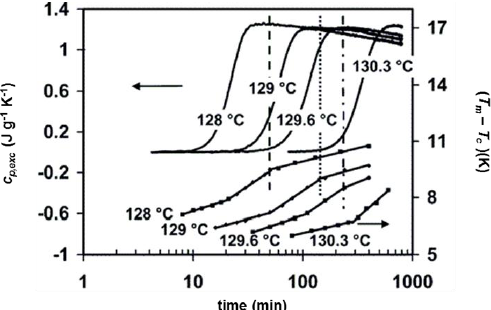
Figure 13. Correspondence between the three stages of the melting temperature ( T m ) evolution, plotted as the difference between the melting temperature and the crystallization temperature ( T c ), and the decay of the excess heat capacity at the indicated crystallization temperature. (Reprinted (adapted) with permission from [60]. Copyright (2004) American Chemical Society).